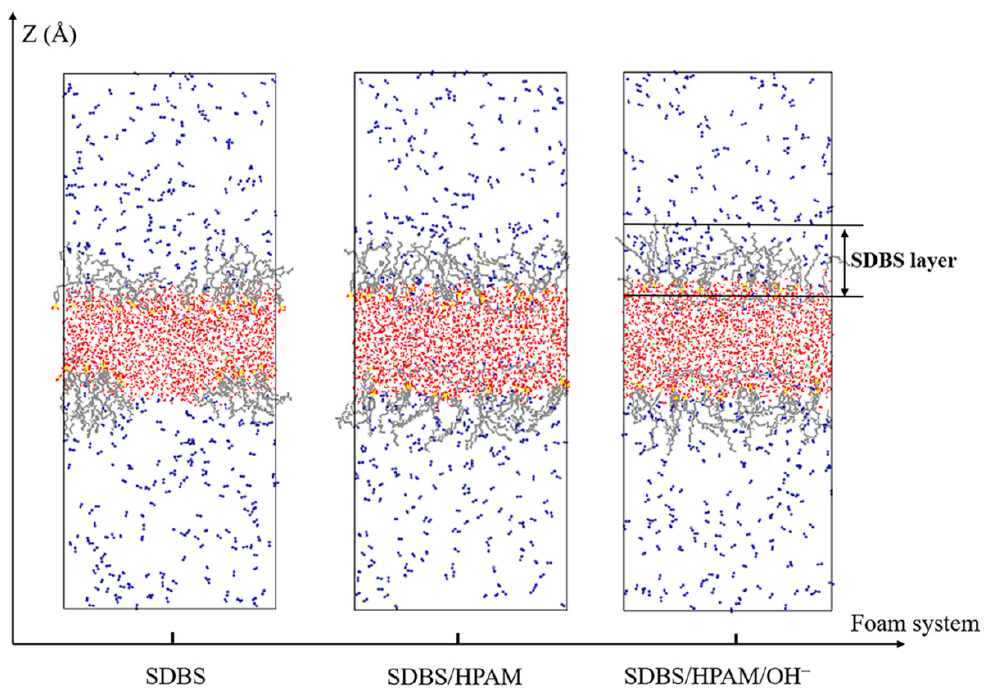
Figure 4. Snapshots of the different foam systems after the relaxation equilibrium.